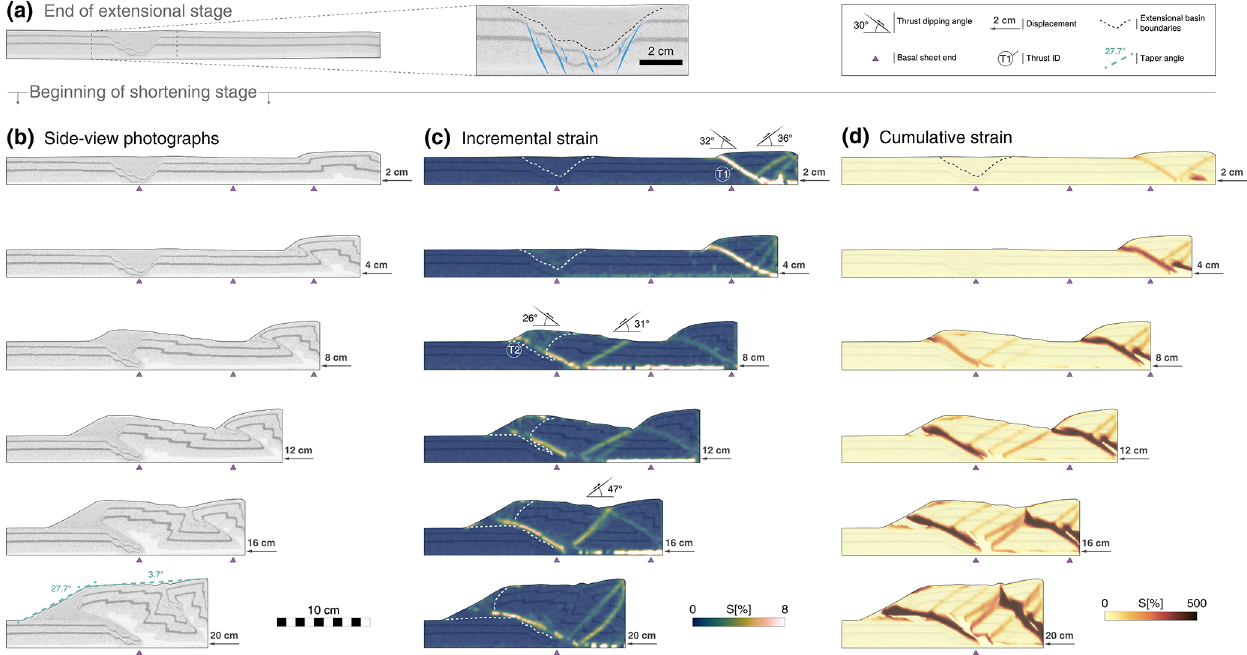
Figure 5. Experiment 1B summary. (a) Side-view photograph and interpreted close-up view at the end of the extensional stage. Shortening stage evolution, showing (b) side-view photographs, (c) incremental strain, and (d) cumulative strain.